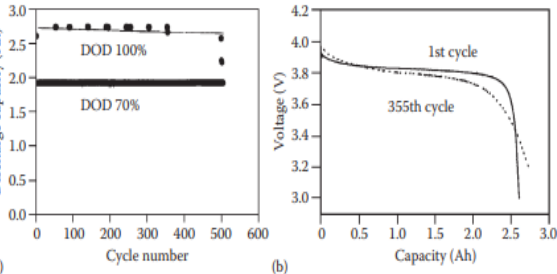
Figure 5. Cycling feature of a 10 Wh solid LIB: ( a ) at various drops of discharge and ( b ) discharge curves in different cycles. The LIB consists of LiCoO 2 as the positive electrode and Li metal as the negative electrode; ethylene oxide and propylene oxide (EO–PO) copolymer are used as electrolyte [70].